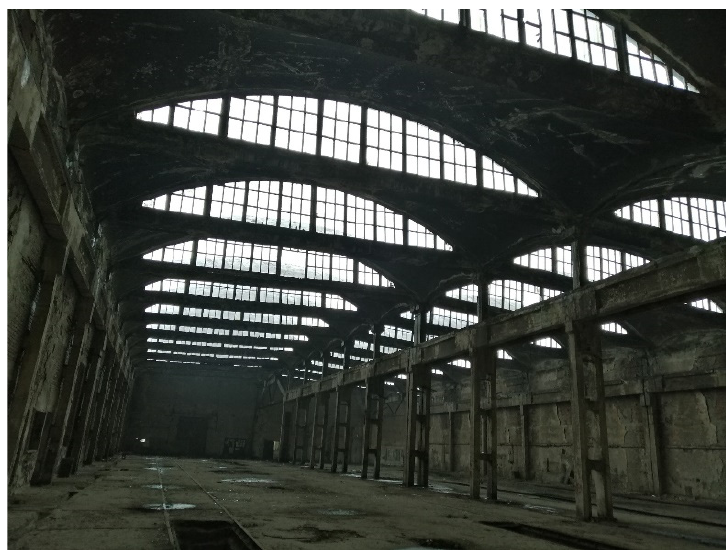
Figure 19. Ilja Doganoff. Current state of the Railway Depot. Source: Author.